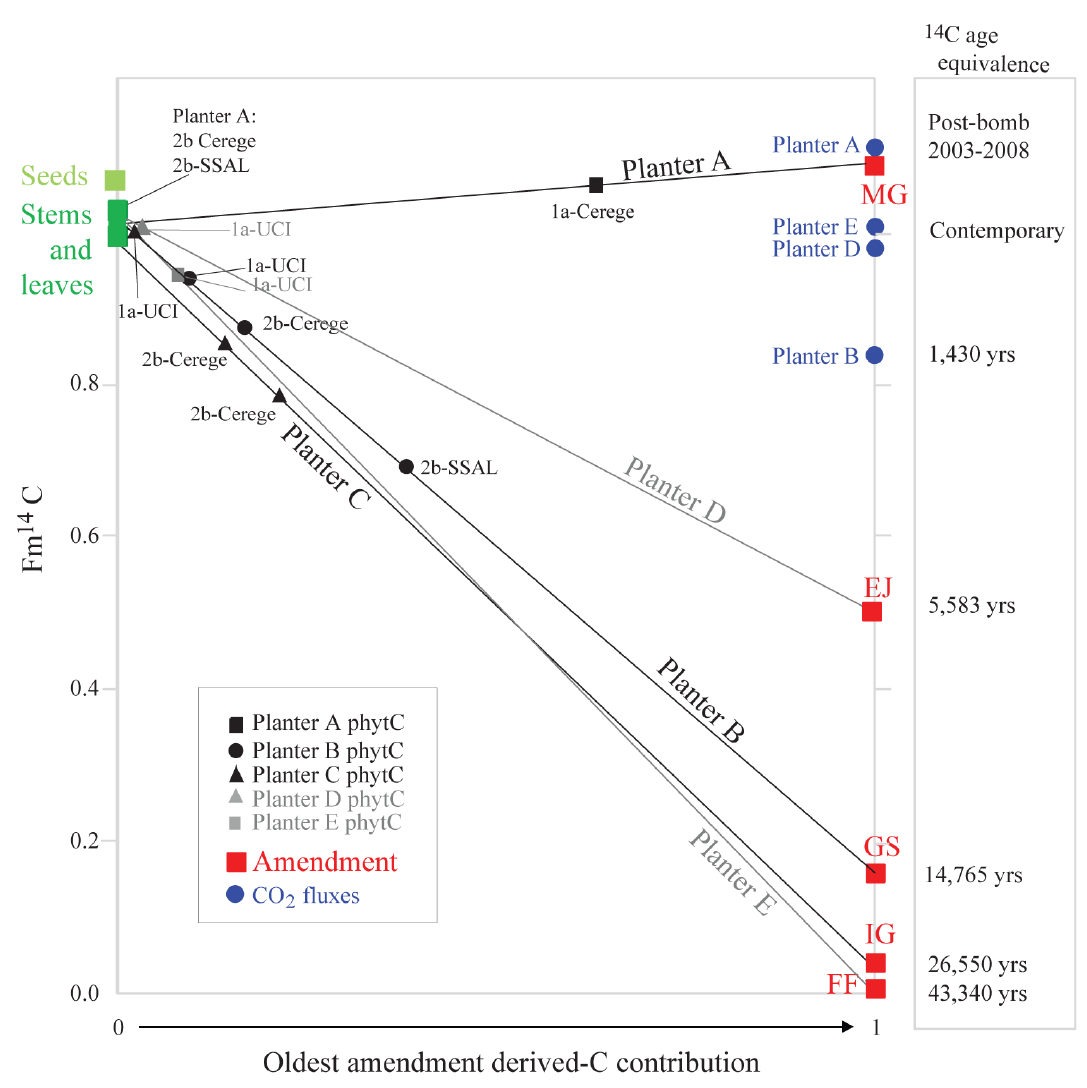
Figure 4. Below-ground C manipulation procedure: oldest amendment-derived C contribution to phytC calculated using the mixing equation (Eq. 1) presented in the text expressing the 14 C signature of phytC as the result of mixing between C derived from plant photosynthesis (seeds, stems and leaves represented by the green squares) and C derived from the oldest amendment (MG, EJ, GS, IG, FF defined in Table 1 and represented by the red squares). Phytolith samples are labeled according to the phytolith extraction protocol used (1a and 2b) and the laboratory of extraction (UCI, CEREGE and SSAL). Selected age benchmarks from substrate amendments and soil CO 2 fluxes are shown for reference on the right